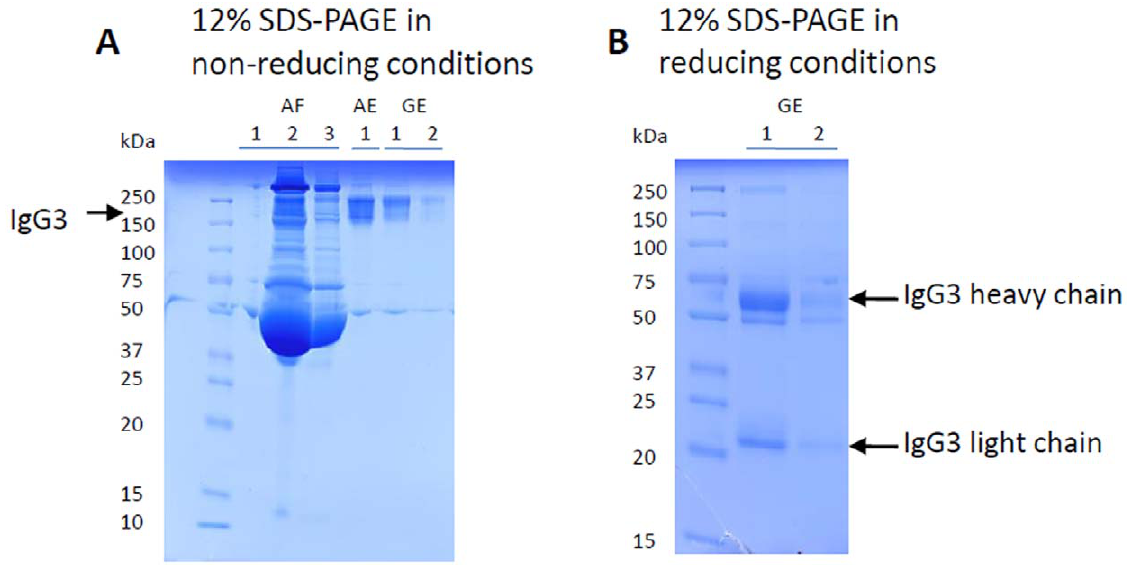
Figure 1. Protein-A and Protein-G purification fractions from the EUA1 plasma sample on an acrylamid gel. A. 12% SDS-PAGE in non- reducing conditions: lines AF1 to AF3: consecutive filtrate fractions of a Protein A column containing plasma proteins including IgG3; line AE: Elution fraction of a Protein A column containing IgG1, IgG2, IgG4; lines GE1 and GE2: consecutive elution fractions of a Protein G column containing IgG3. B. 12% SDS-PAGE in reducing conditions: lines GE1 and GE2: consecutive elution fractions of a Protein G column containing